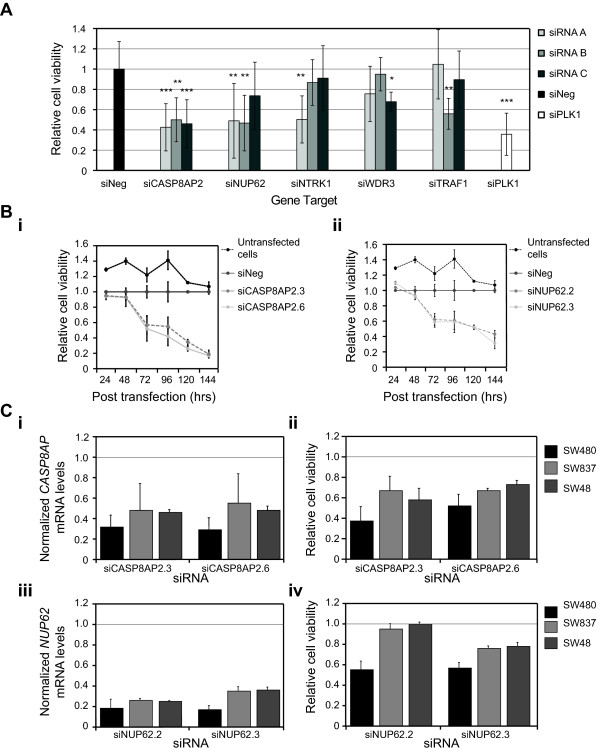
RNAi identifies CASP8AP2/FLASH and NUP62 as essential for the viability of SW480 cells. (A) The relative viability of SW480 cells following transfection of three different siRNAs targeting each of the genes shown (see Methods for the identity of each siRNA). Data is shown as the mean ± SD of three independent transfections for each siRNA targeting the six genes of interest, normalized to the average viability of SW480 cells transfected with the negative control siRNA (siNeg; eight independent transfections). The normalized data for the positive control siRNA, siPLK1, (six independent transfections) is also shown. The statistical comparison (t-test of unequal variance) of siNeg transfected cells to cells transfected with the siRNAs corresponding to the stated genes is indicated by *** = p ≤ 0.001, ** = p ≤0.01, and * = p ≤0.05. (B) The effect of silencing (i) CASP8AP2/FLASH and (ii) NUP62, over 144 hours, on cell viability and their respective mRNA levels in SW480. The data shown represents the mean and standard deviation for three transfections per condition per time point normalized to the data from cells transfected with the negative control siRNA, siNeg. (C) The effect of silencing CASP8AP2/FLASH and NUP62 on their respective mRNA levels (i and iii) and on cell viability (ii and iv) in three SW480, SW837 and SW48 colorectal cancer cell lines. The data shown represents the mean and standard deviation for three transfections per condition per time point normalized to the data from cells transfected with the negative control siRNA, siNeg.